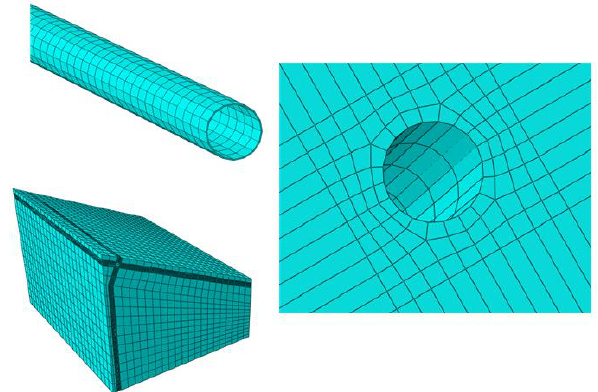
Figure 5. Schematic illustration of mesh division.